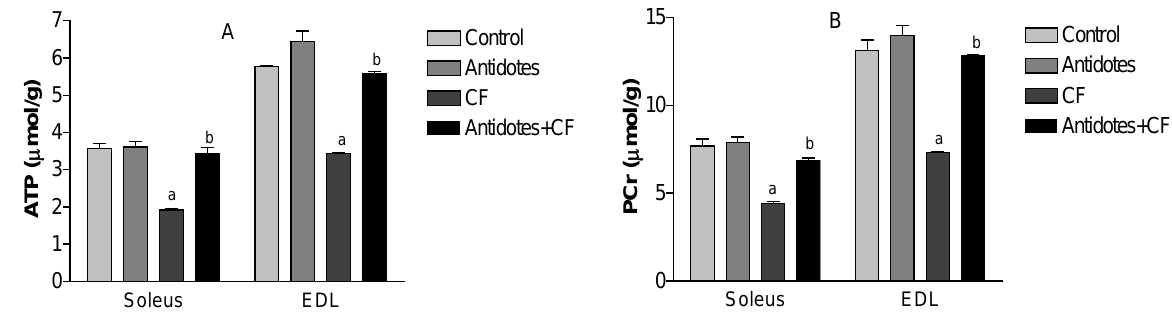
FIGURE 8. Protection by antidotes (MEM, 18 mg/kg and ATS, 16 mg/kg) of CF (1.5 mg/kg)–induced changes in high-energy phosphates (A) ATP and (B) PCr in soleus and EDL muscles of rats. Animals were sacrificed 60 min after last injection. Each value presented as mean ± SEM (n = 4–6). a Significant difference between values from controls and treated rats ( p < 0.05). b Significant difference between values from CF and Antidotes+CF–treated rats ( p <